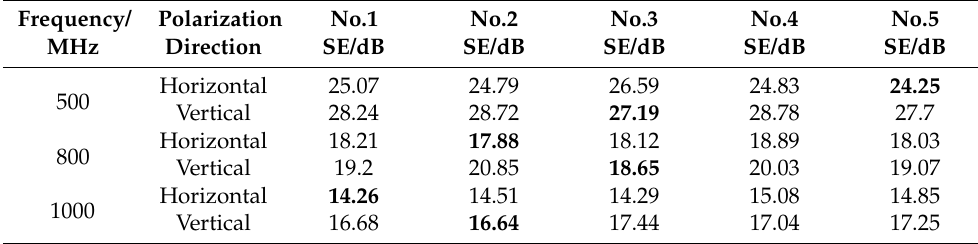
Table 4. Shielding effectiveness of test chamber observation points from No.1 to